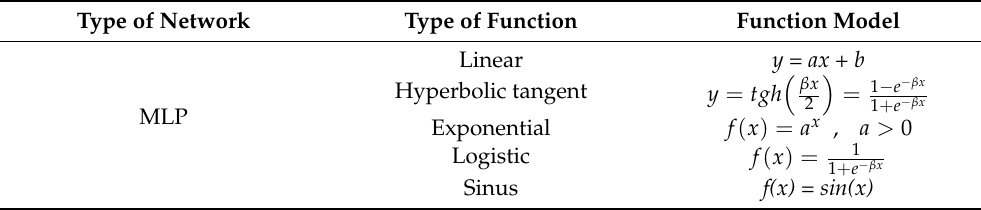
Table 2. The activation functions of the hidden and output layer used to train MLP network. Type of